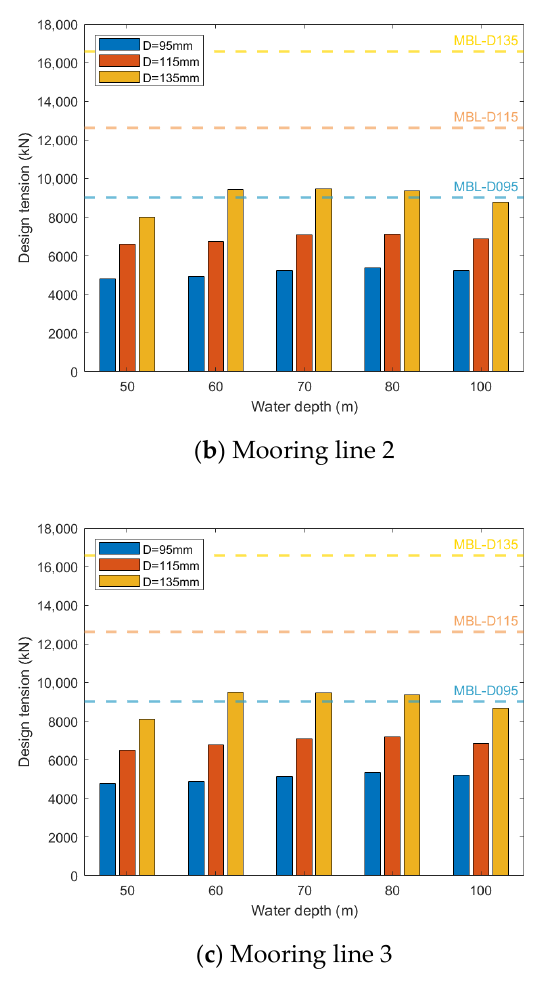
Figure 9. Design tension of each mooring line for the different water depths.